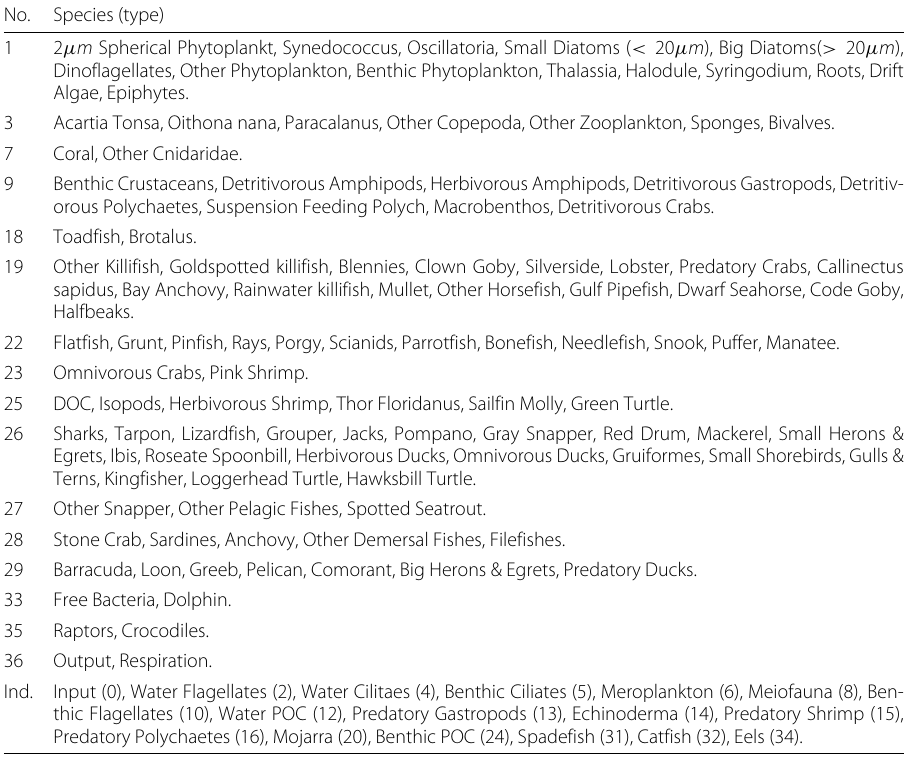
Table 1 Siblinarity communities, based on common prey and common predators in the Florida Bay food